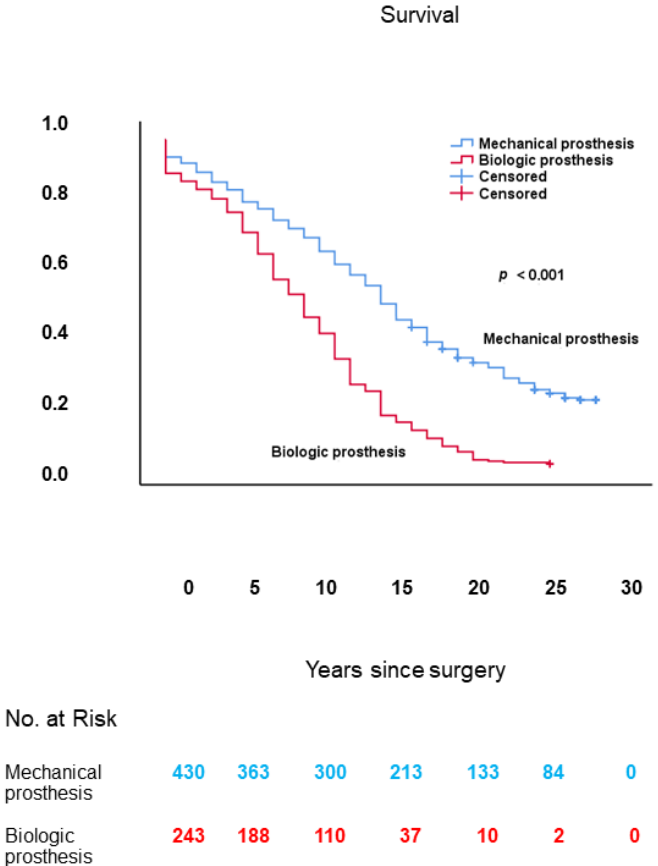
Figure 7. Kaplan–Meier survival curves of patients with a biologic vs. those with a mechanical aortic valve prosthesis.